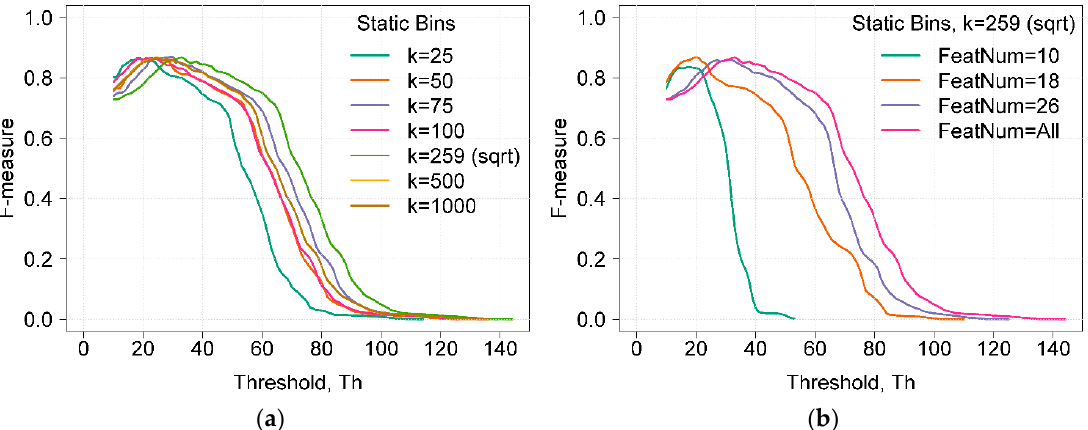
Figure 2. ( a ) Dependence of the F-measure on the detection threshold Th using static bins and a different number of bins k . ( b ) Dependence of the F-measure on the detection threshold Th using static bins at different feature sets.